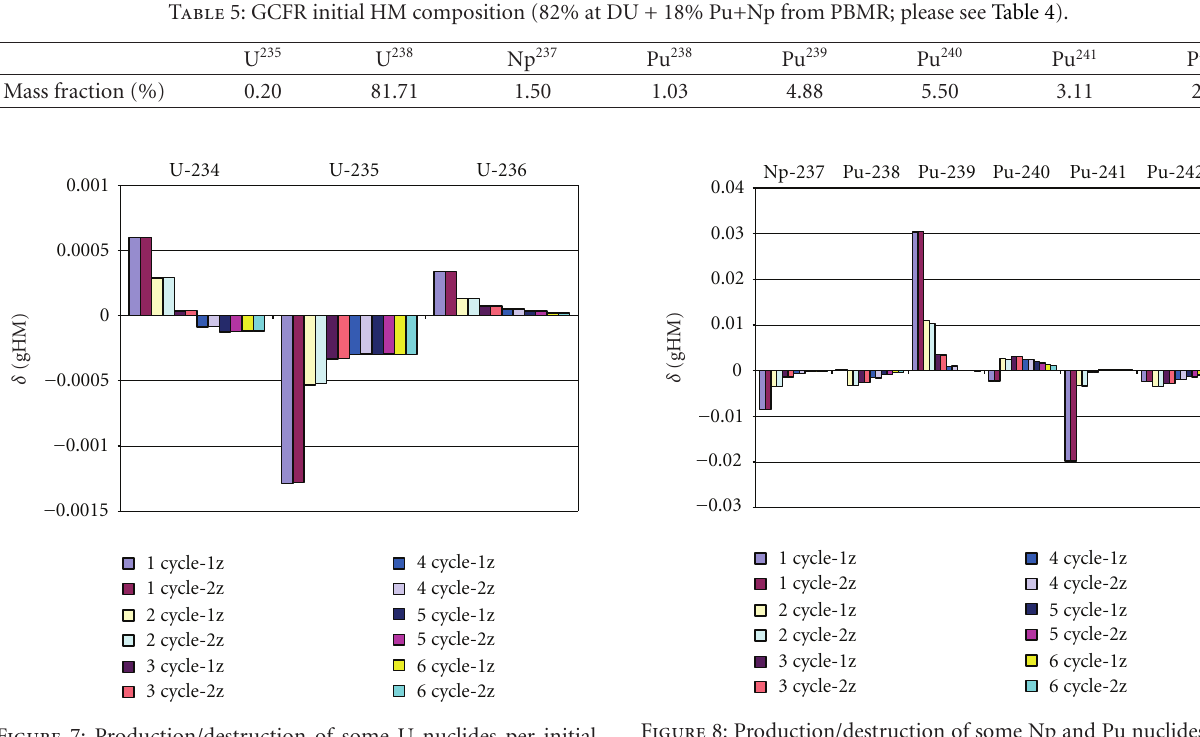
Figure 7: Production/destruction of some U nuclides per initial HM mass in the di ff erent GCFR core models, for each recycle.